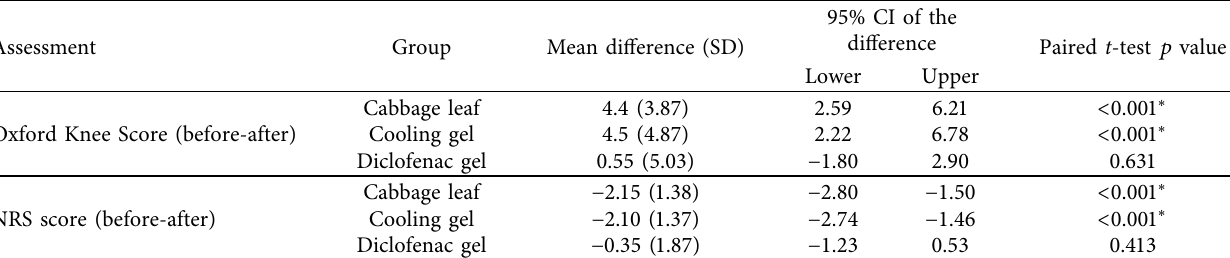
Table 2: Comparison of the mean difference between the three groups by using the paired t -test.